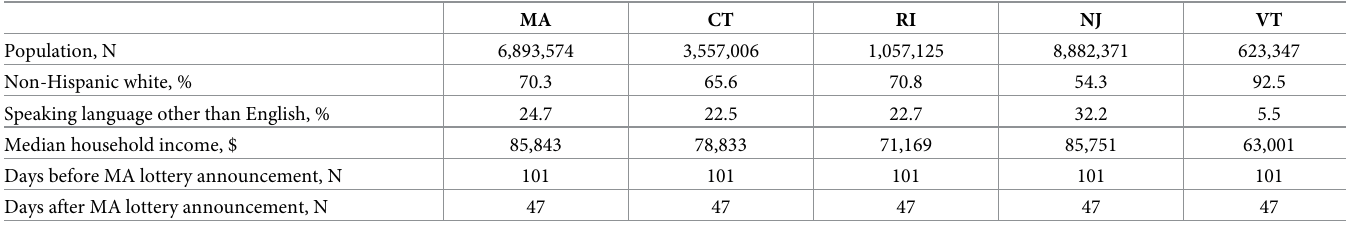
Table 2. Descriptive statistics for state-level characteristics in 2020.